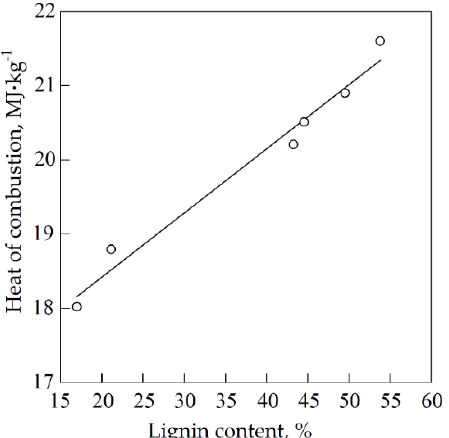
Figure 1. Heat of combustion of dry, ash-free and extractive-free biomass of different plant species seed coatings as a function of the lignin content [17].